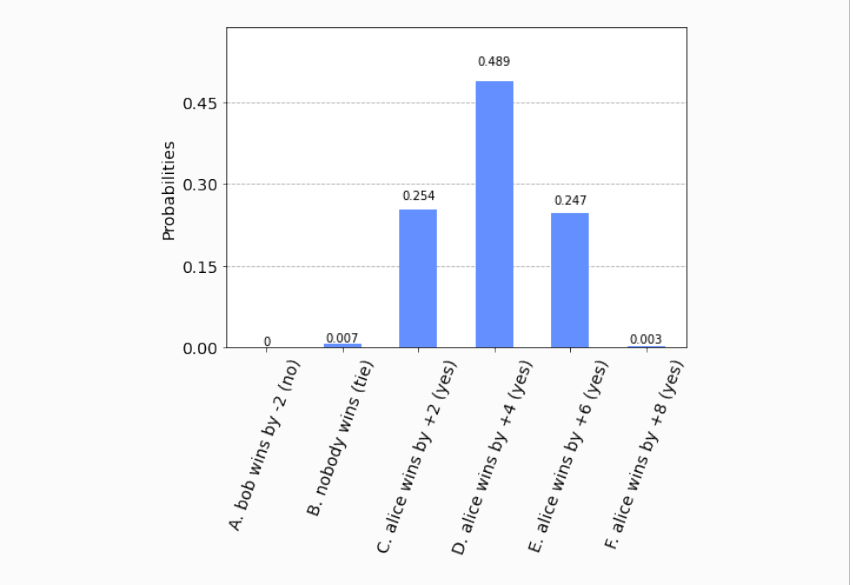
Figure 19. The possible outcomes and their probabilities with 2 independent legislators and r A = r B = 0.1.